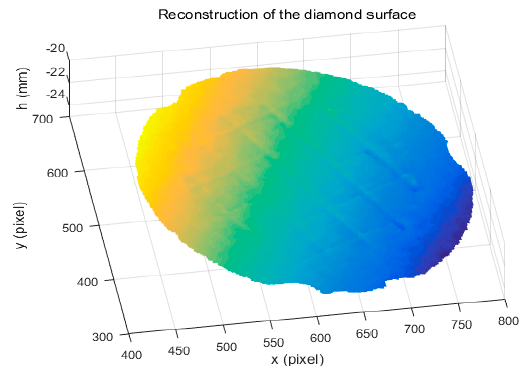
Figure 11. Reconstruction of the reflected diamond distribution surface object.